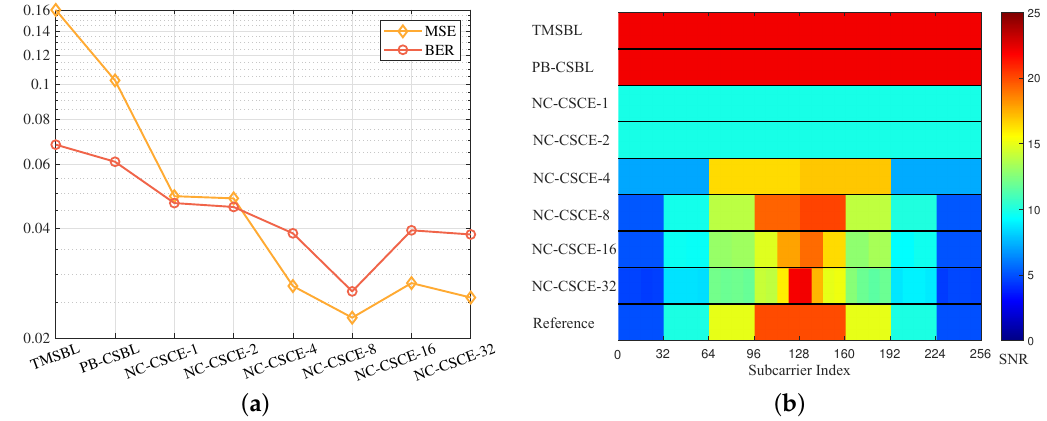
Figure 7. The performance comparison of different algorithms under colored noise: ( a ) the MSE and BER performance; and ( b ) the estimated SNRs over all